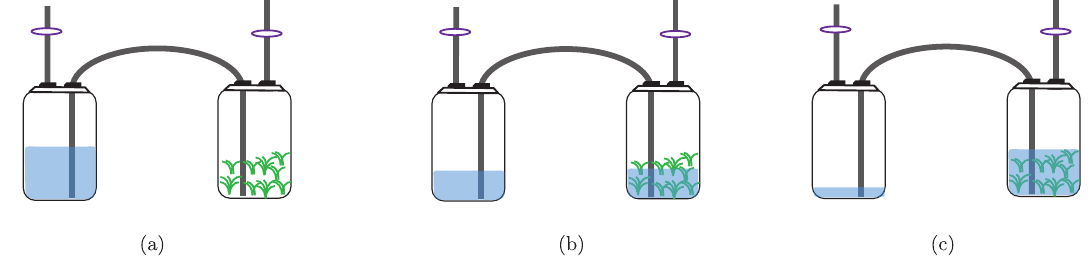
Figure 2. Operating cycle of the TIB: ( a ) non-immersed stage; ( b ) beginning of the immersed stage; and ( c ) immersed stage.